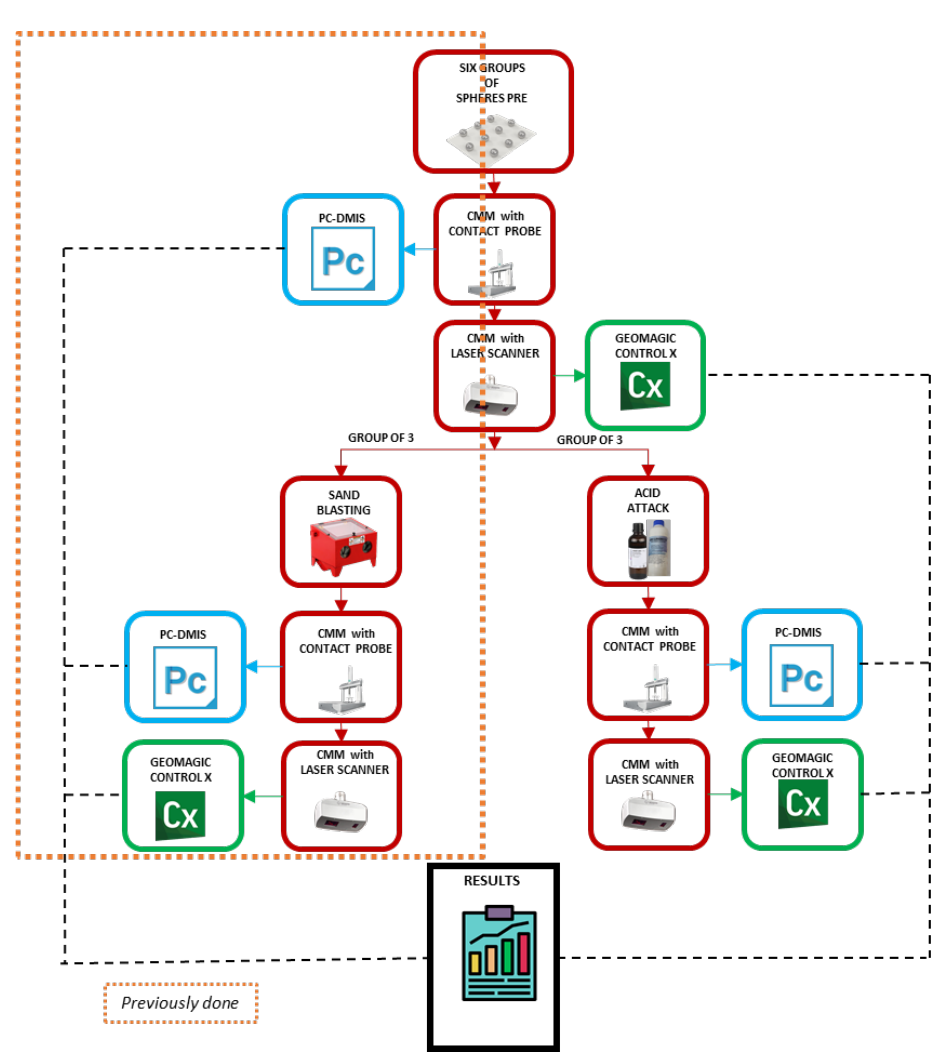
Figure 4. The full methodology of the experimentation.